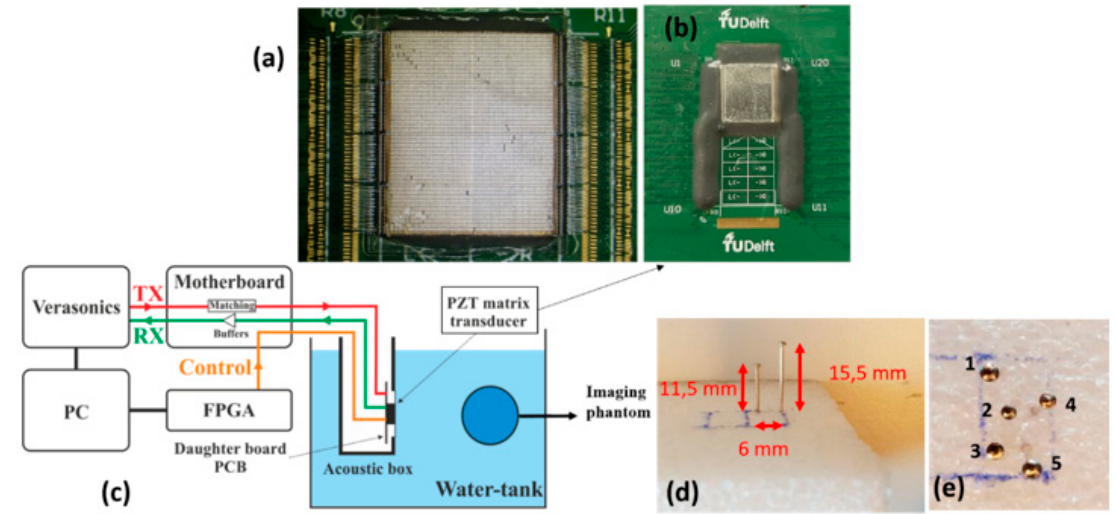
Figure 3. ( a ) The daughterboard with the transducer array before applying the ground foil. ( b ) The finalized 4 × 2 matrix array. ( c ) Schematic of the measurement setup. ( d ) The imaging phantom: a foam pad with two needles. The distance between the foam and the transducer surface is about 26 mm. ( e ) The imaging phantom: a foam pad with five needles, positioned in di ff erent depths (from 10 to 20 mm). The distance between the foam and the transducer surface is about 28 mm. The numbers next to the needles are used for target localization in Section